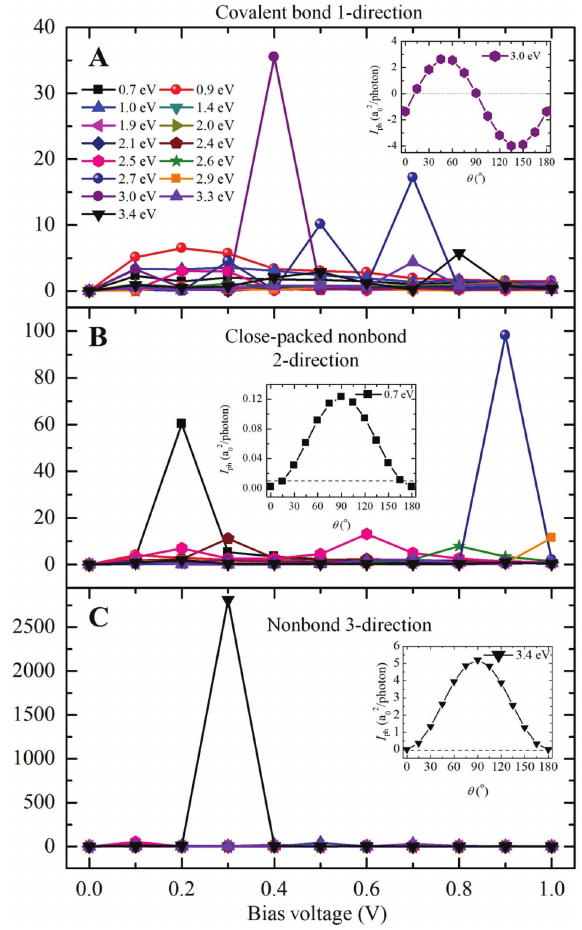
Figure 4: The photon energy-dependent extinction ratio in bilayer tellurene.